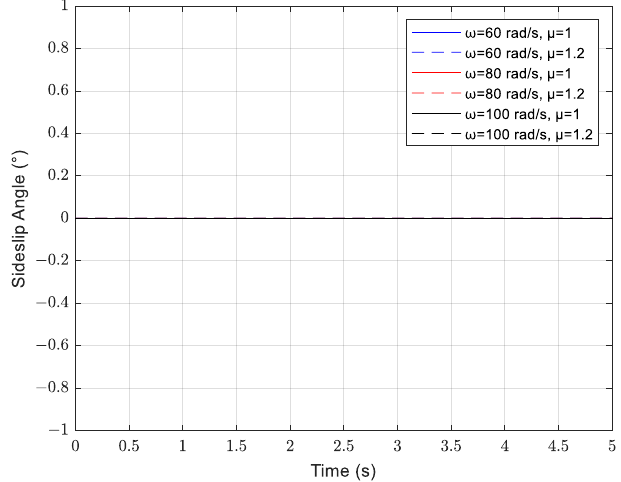
Figure 6. Response of Sideslip Angle.